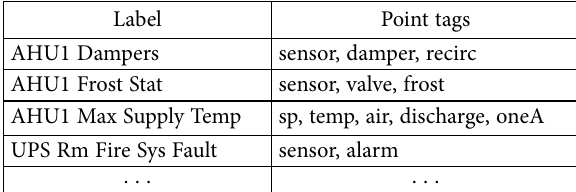
Table 3. Example of tagged data (other categories have been removed from the table for simplicity)